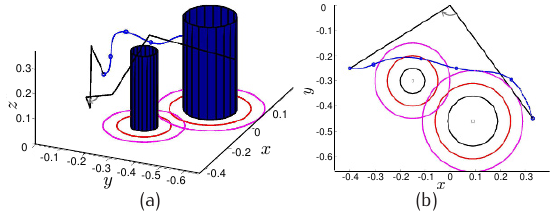
Table 3. Safety Parameters for ExperimentalStudy.